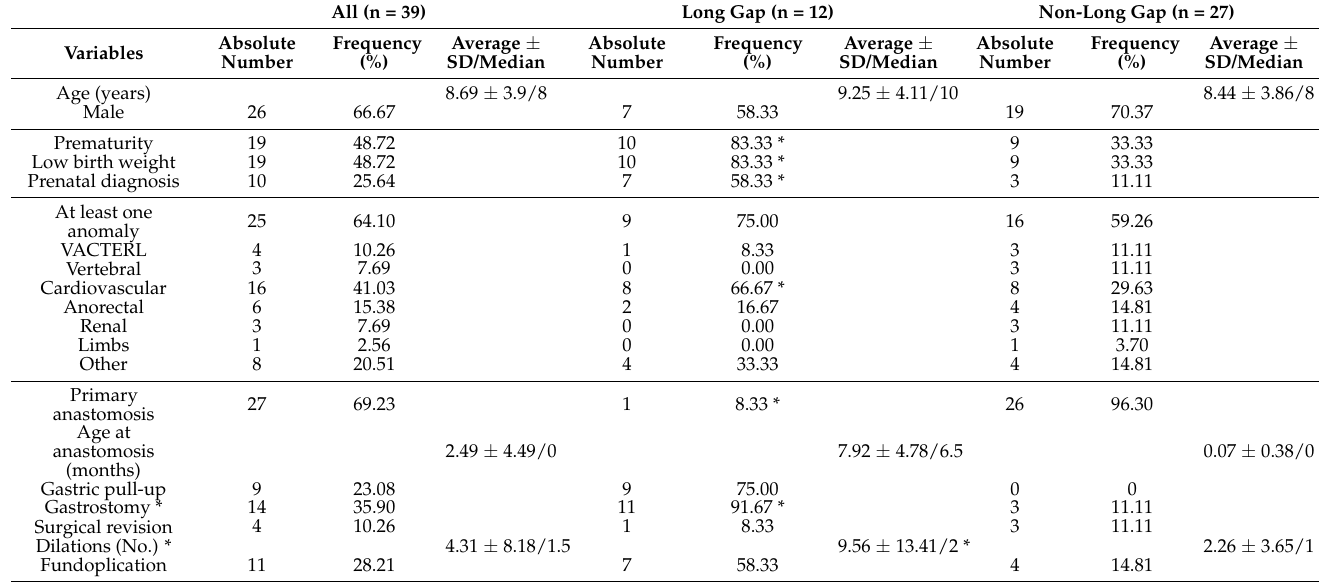
Table 1. Clinical features of patients according to the presence of Long